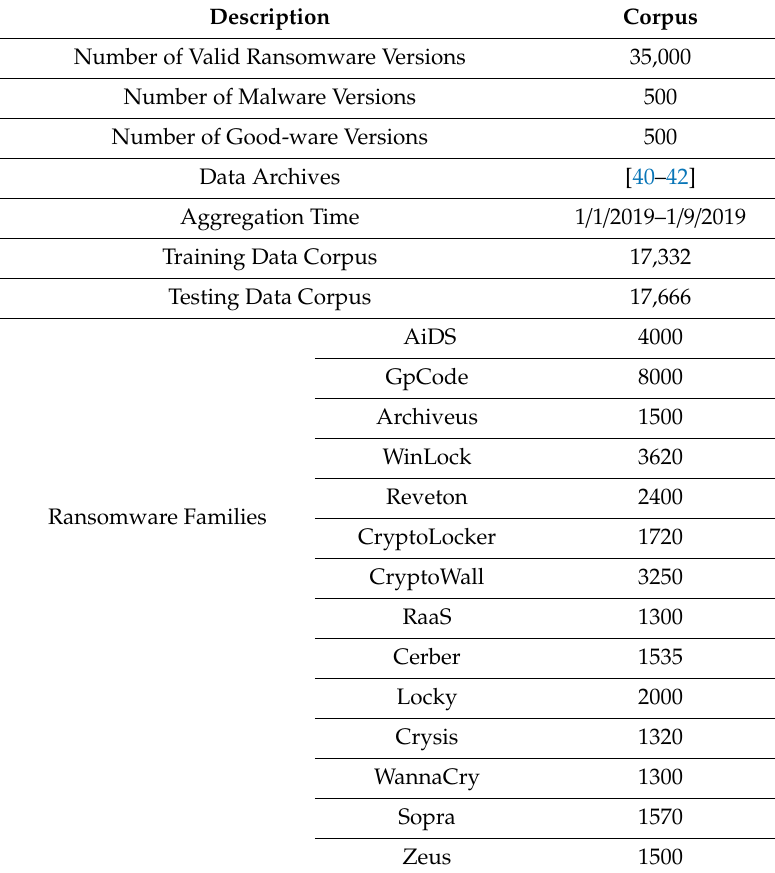
Table 5. The corpora of